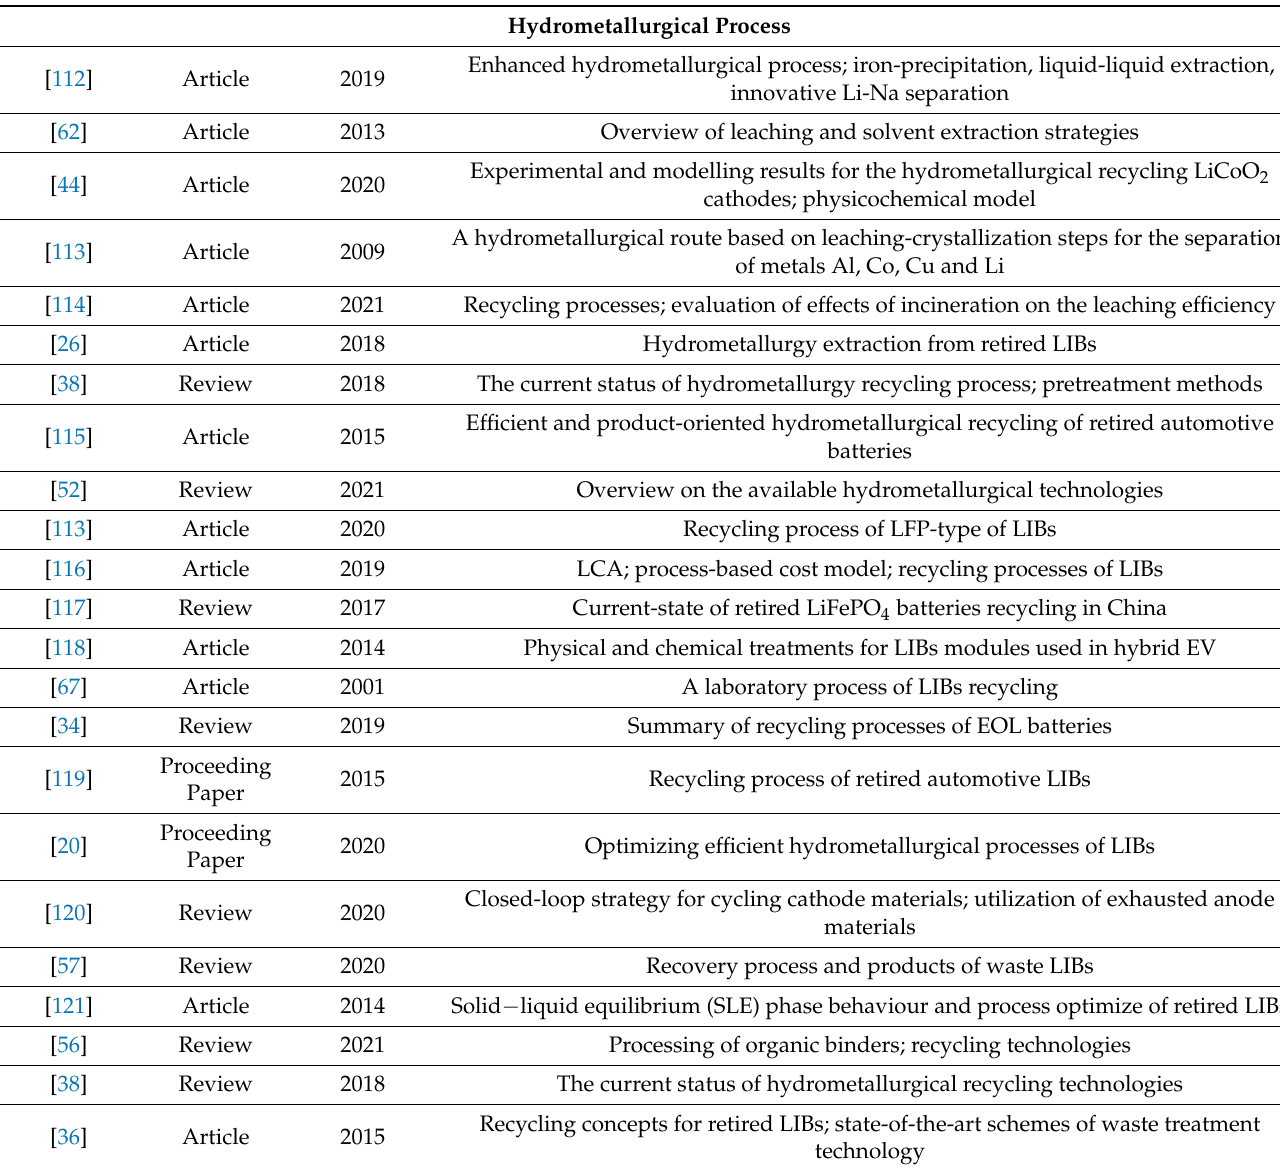
Table A4. Assessed literature in review for “Hydrometallurgical Process” category.